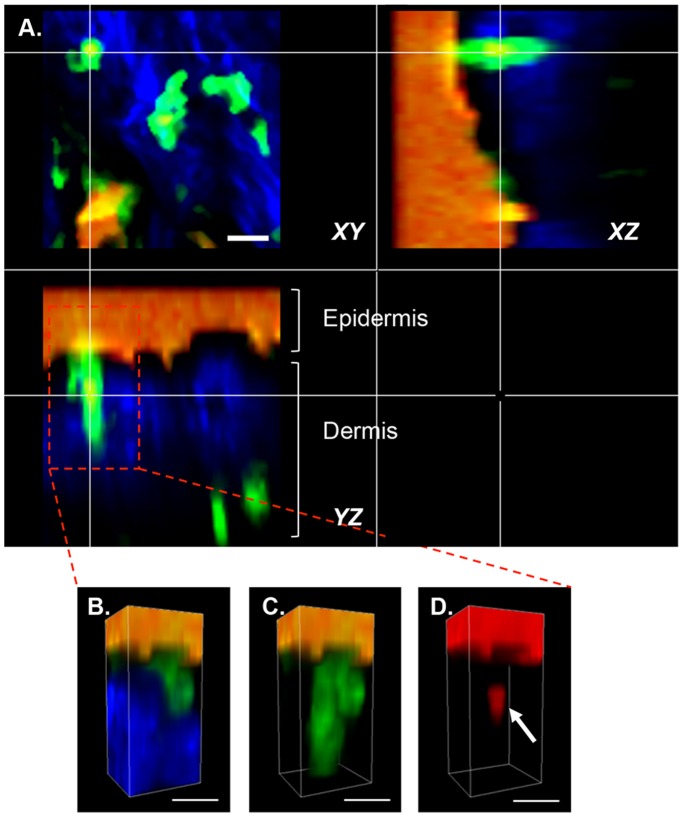
Two-photon microscopy (2 PM) visualization of DDC uptake of antigen.(A) Orthogonal views (XY, XZ, YZ) through a DDC illustrating colocalization of DDC (green), TMR-SIINFEKL (red) and collagen (blue). Colocalization is visible as a yellow colour and orange represents the leakage of intense red fluorescence into the green channel. (B–C) 3D images of the DDC from (A). All channels are shown in (B), blue has been dropped out in (C) and both blue and green in (D). TMR-SIINFEKL uptake by the DDC is shown in (D) indicated by arrow. Scale bar is 20 µm.